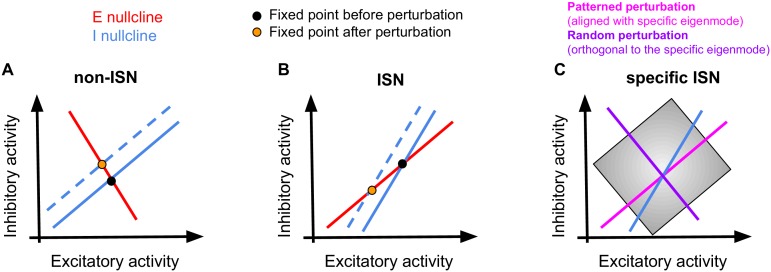
Paradoxical effects of perturbing inhibition in ISNs and specific ISNs.(A) Effect of perturbing the inhibitory population in networks with weak coupling of excitatory and inhibitory populations (non-ISNs). Here, increasing the activity of inhibitory neurons (demonstrated by the shift in the I nullcline from the solid blue line to the dashed one) leads to a new fixed point with higher inhibitory and lower excitatory activity, in the expected direction. (B) In networks with strong coupling of excitation and inhibition, increasing the input to inhibition leads to a new fixed point with lower activity of both excitation and inhibition. Perturbation of inhibition, therefore, changes the activity of the inhibitory population in a paradoxical direction. (C) In specific ISNs, patterned stimulation of the network can change the fixed point (in the specific direction; ‘specific fixed point’) either in ISN or non-ISN fashion, depending on the alignment of the perturbation pattern with the specific eigenmode of the network. Perturbation patterns aligned with the specific eigenmode (magenta) change the specific fixed point in the ISN direction (similar to (B)), hence leading to the specific paradoxical effect. Perturbation patterns orthogonal to the specific eigenmode (purple) change the specific fixed point in the non-ISN direction (similar to (A)), hence failing to reveal the specific paradoxical effect.